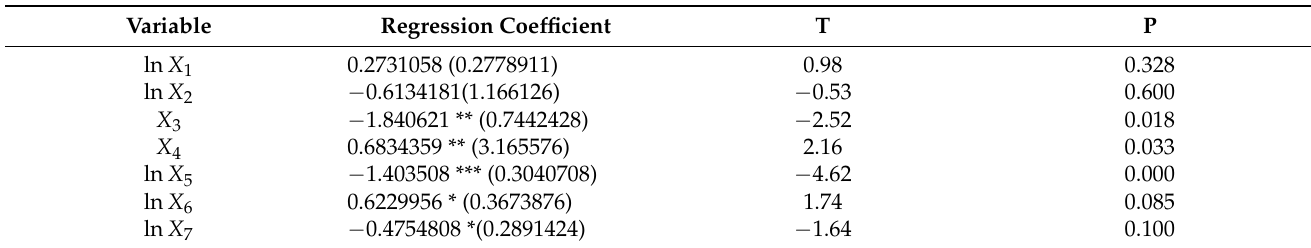
Table 5. Regression